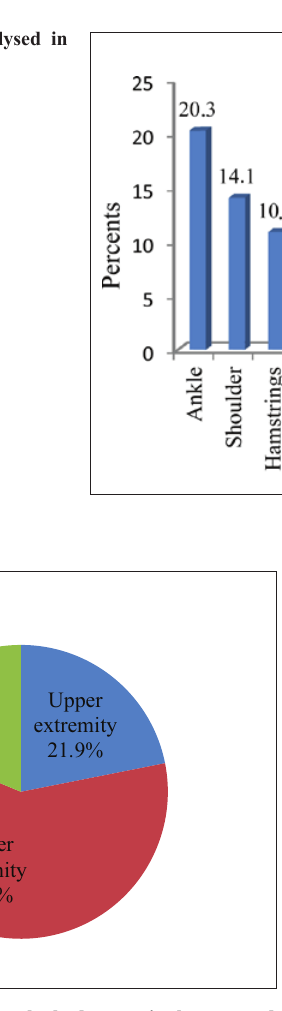
Figure 2. Distribution of injury cases by body parts in thrower and sprinter cohorts